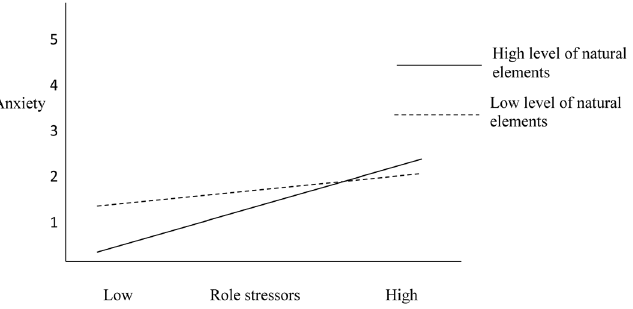
Fig 2. Natural elements exposure as a moderator of the relationship between role stressors and